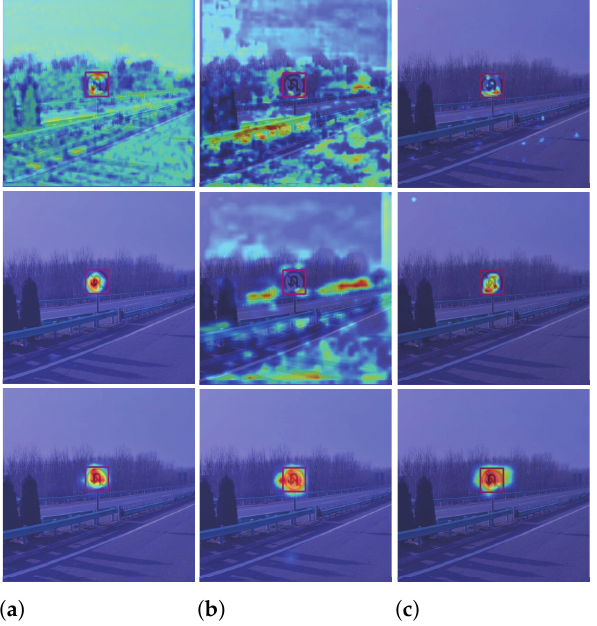
Figure 9. Visualization results of three scales of feature maps for different models: ( a ) Yolov5s. ( b ) SEDG-Yolov5 before distillation. ( c ) SEDG-Yolov5 after